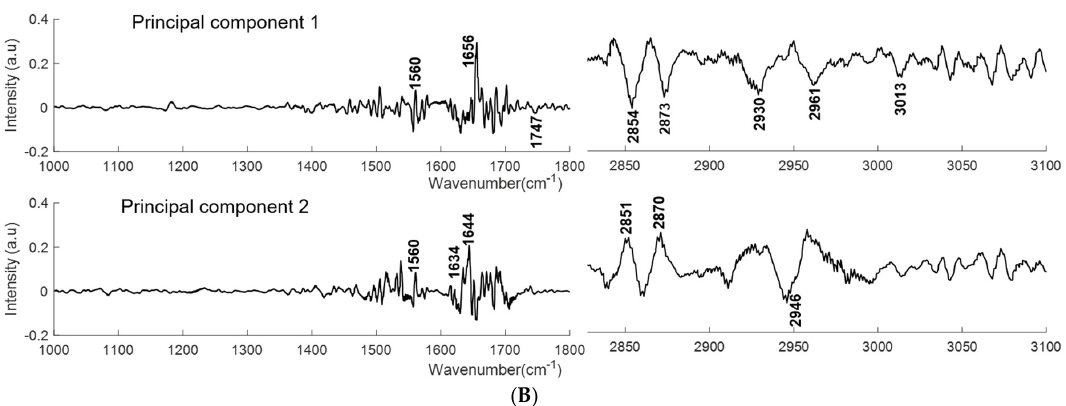
Figure 4. PCA of plasma spectra from patients from baseline through therapy and up to eight months follow up. ( A ) Score plots are shown for patients at baseline (blue), post hormone (red), post radiotherapy (yellow), two months follow up (purple) and eight months follow up (green) ( B ) PC-1 and PC-2 loading plots for regions 1000–1800 cm − 1 and 2800–3100 cm − 1 . Covariance ellipses (95% confidence) are shown for each class.